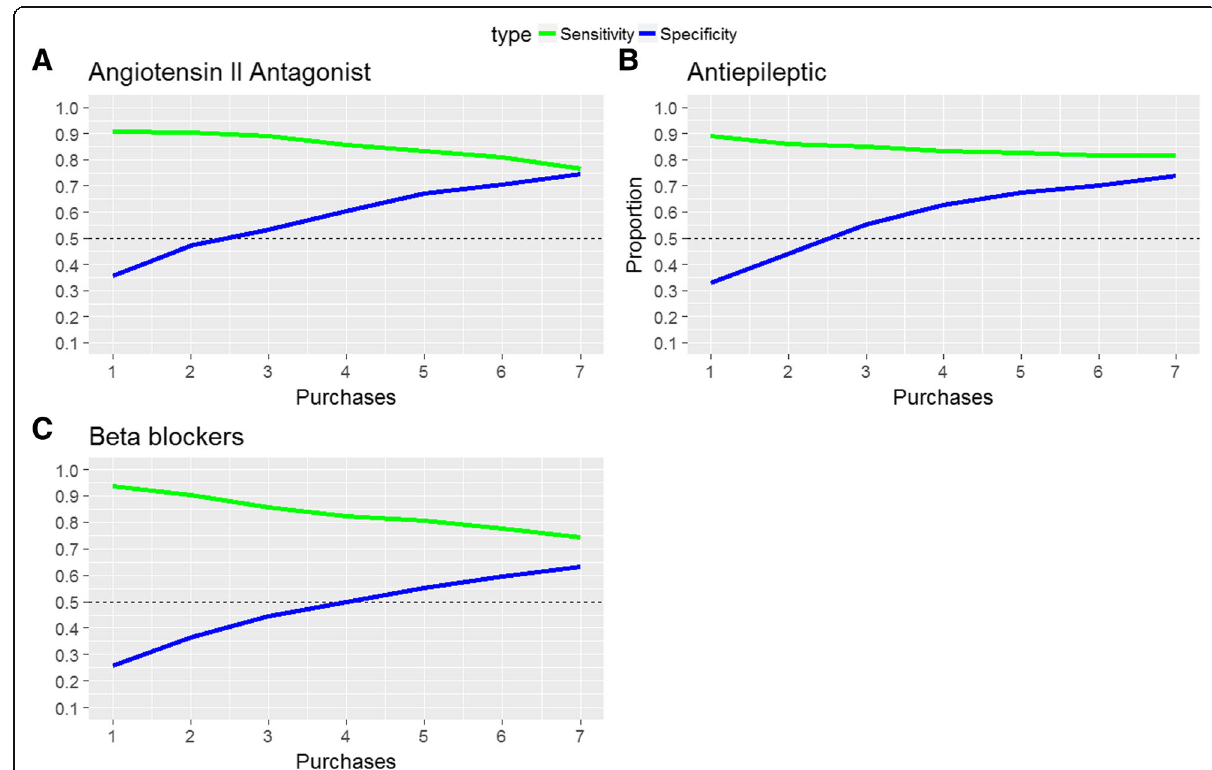
Fig. 4 The sensitivity, specificity, and accuracy of predicting positive treatment response for prophylactic treatment. The figure presents the sensitivity (green), and specificity (blue) at different thresholds of minimum number of purchases to predict a positive treatment outcome. Letters referrers to the three different prophylactic treatments most commonly used, a Angiontensin II Antagonist, b Antiepileptic, & c Beta